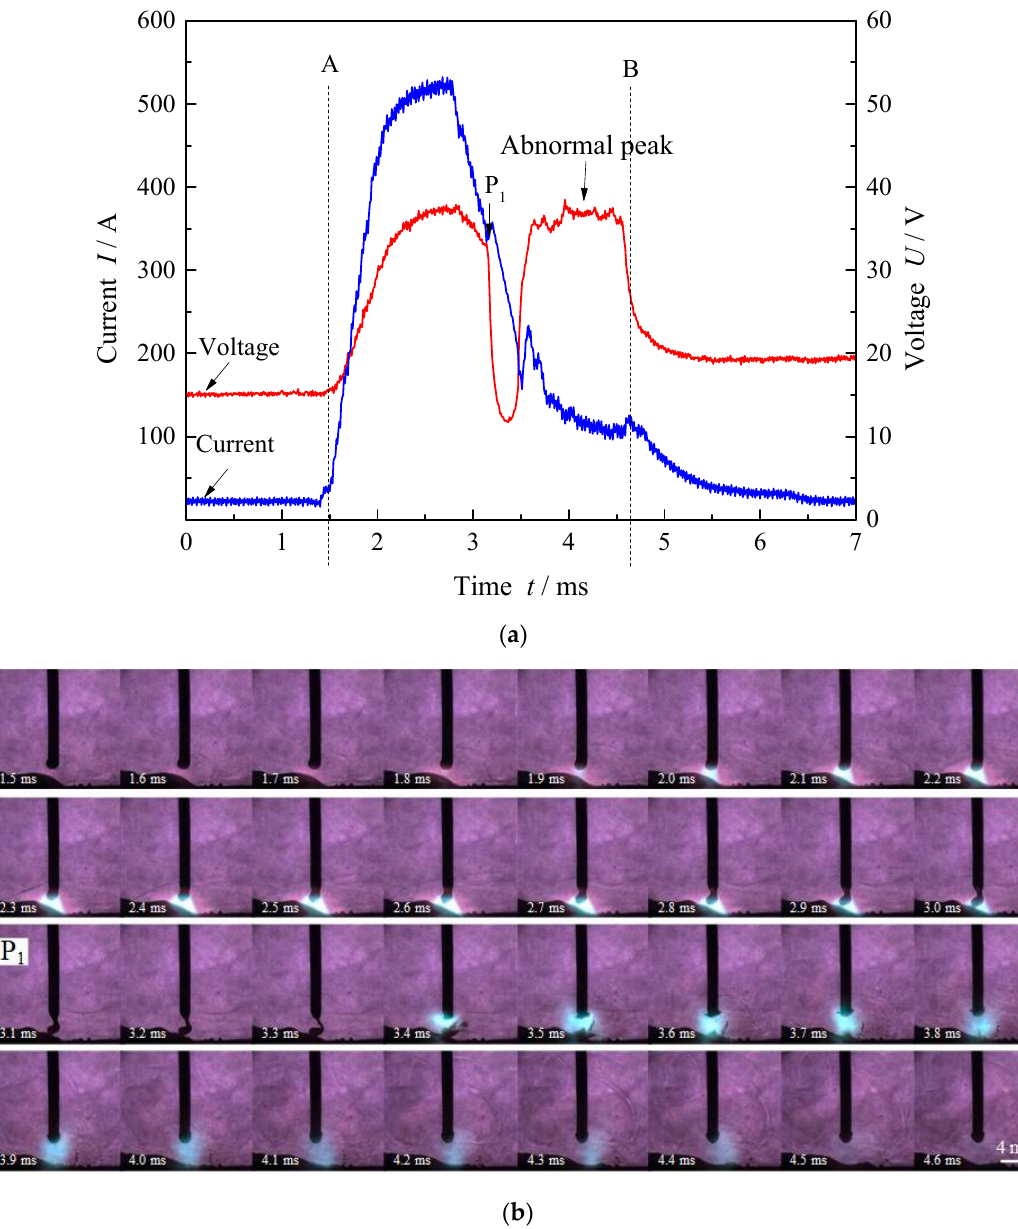
Figure 5. The normal short circuit: ( a ) The welding current and voltage waveform; ( b ) the high-speed photographs of interval AB.